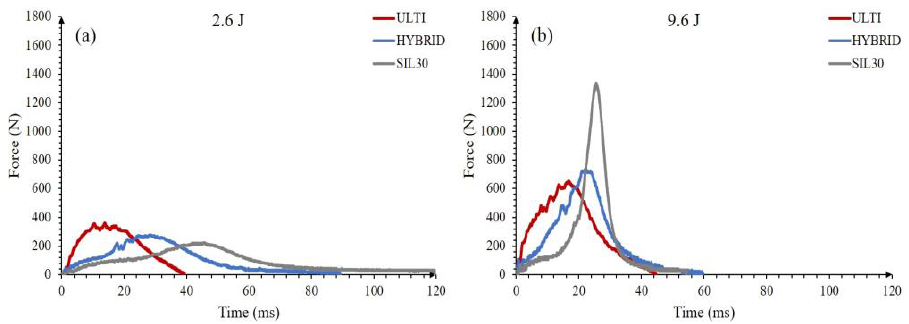
Figure 8. Force response of double stacked vertically-graded configurations; ( a ) 2.6 J, ( b ) 9.6 J.